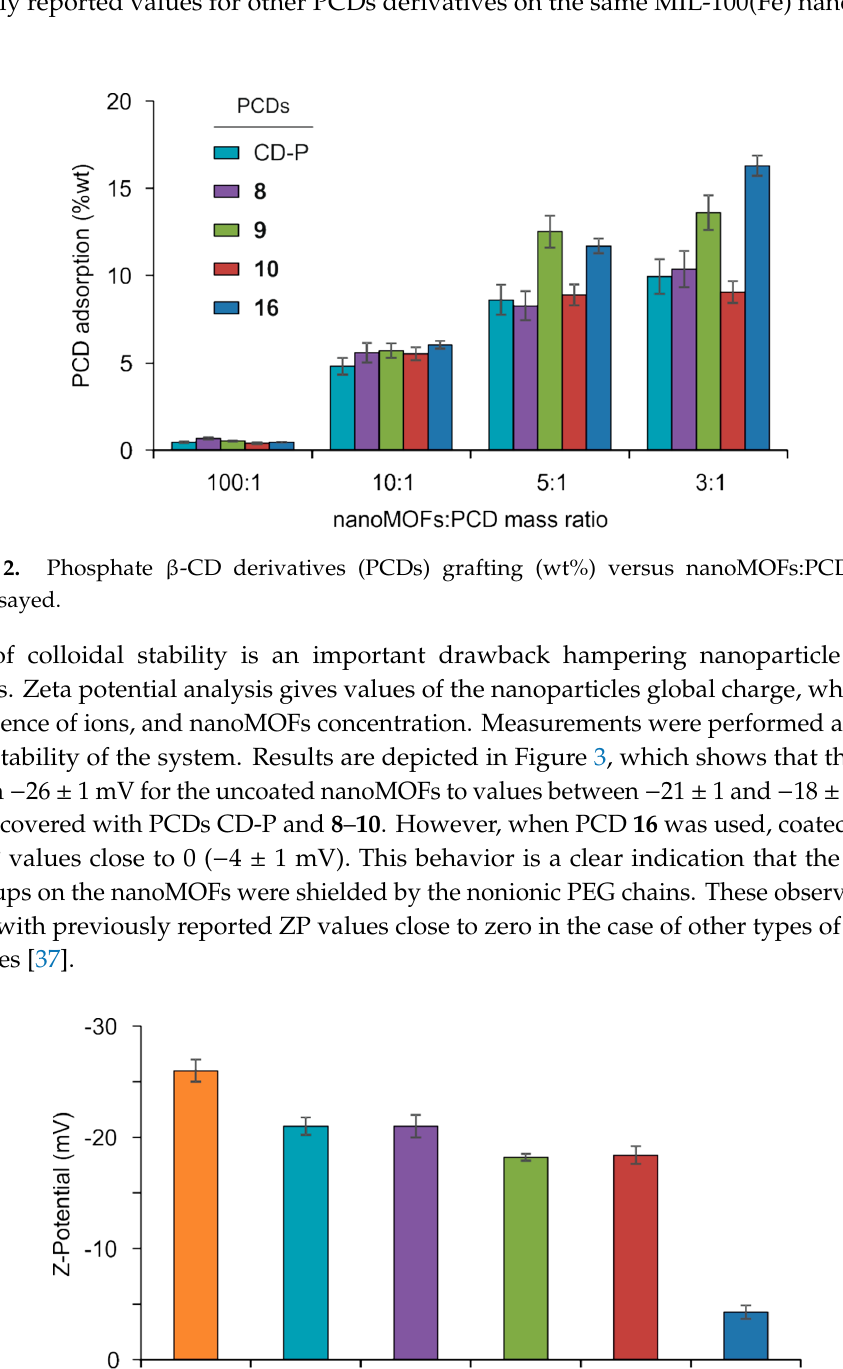
Figure 1. TEM images of nanosized metal-organic frameworks (nanoMOFs) before and after coating step: ( a ) Uncoated nanoMOFs; ( b ) nanoMOFs@CD-P; ( c ) nanoMOFs@ 8 ; ( d ) nanoMOFs@ 9 ; ( e )